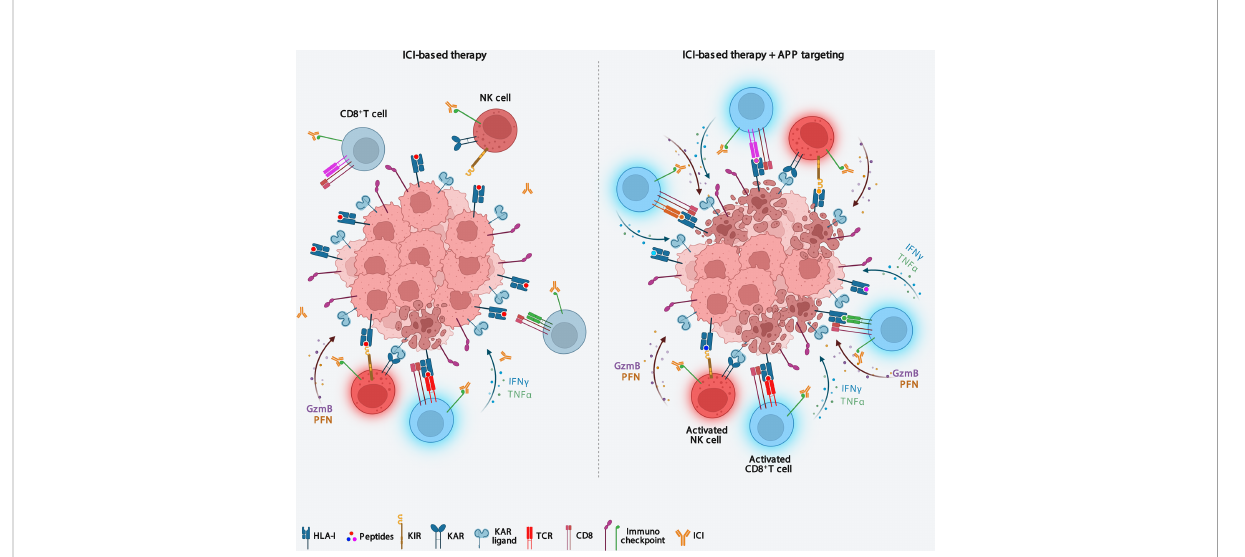
FIGURE 2 Targeting antigen processing and presentation machinery immunosensitizes ICI-resistent tumors. Downmodulation of APP components causes both an increase in tumor immunogenicity and the recall of functional effector CD8 + T cells and NK cells into the tumor microenvironment, thus making tumors sensitive to ICI-based immunotherapy. APP, antigen processing and presentation; ICI, Immune checkpoint inhibitor; KIR, killer inhibitory receptor; KAR, killer activating